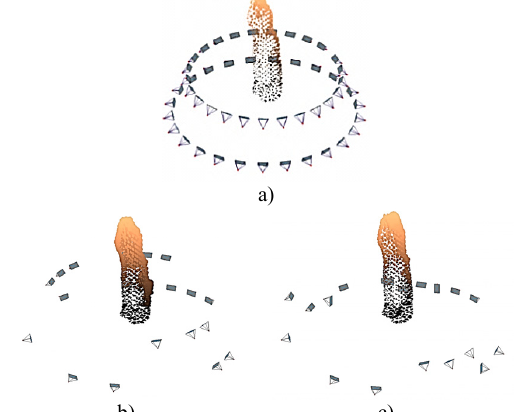
Figure 7. Imaging configuration of the facade